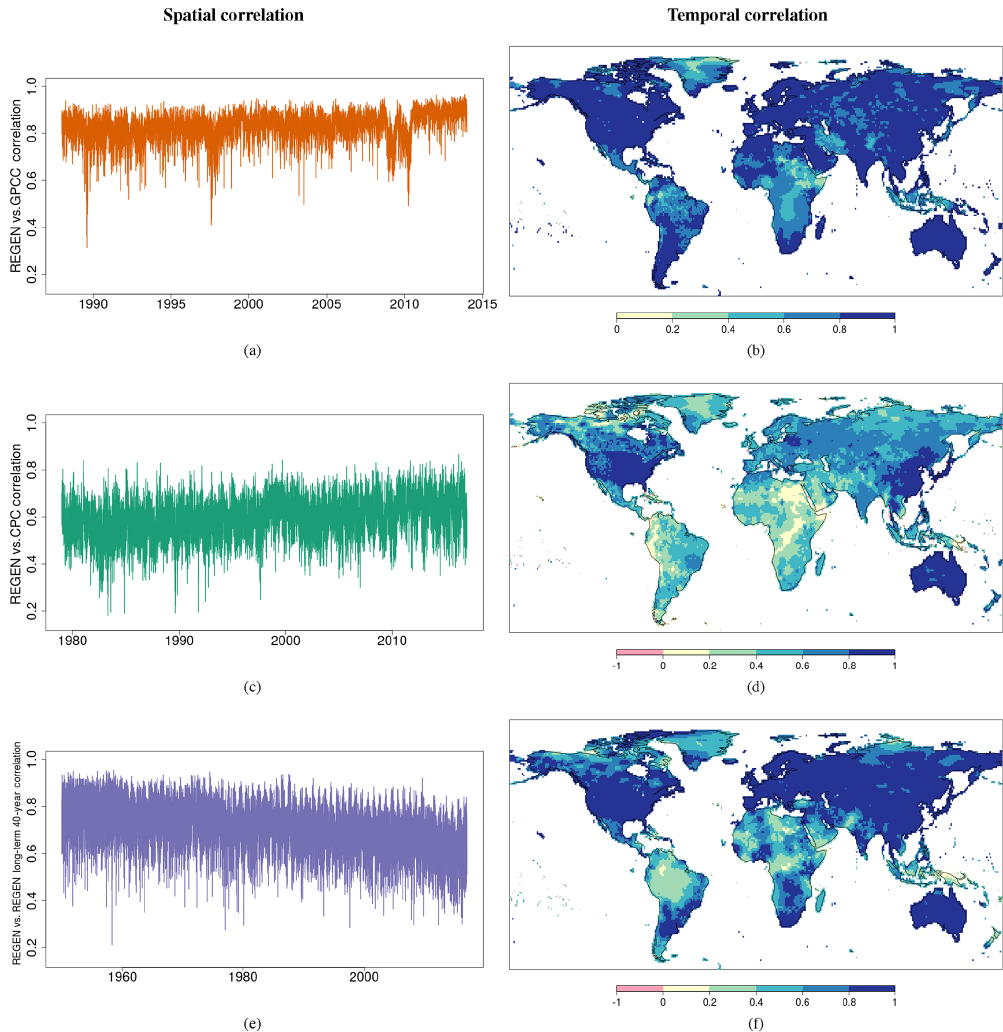
Figure 12. Spatial (field) correlation at each daily time step (a, c, e) and temporal correlation between time series at each grid cell (b, d and, f) between REGEN and GPCC (a, b) , REGEN and CPC (c, d) , and REGEN and REGEN40YR long-term (e, f) data. Comparisons are over the entire common temporal period between each dataset pair (1988–2013 for REGEN vs. GPCC-FDD1, 1979–2016 for REGEN vs. CPC and 1950–2016 for REGEN vs.